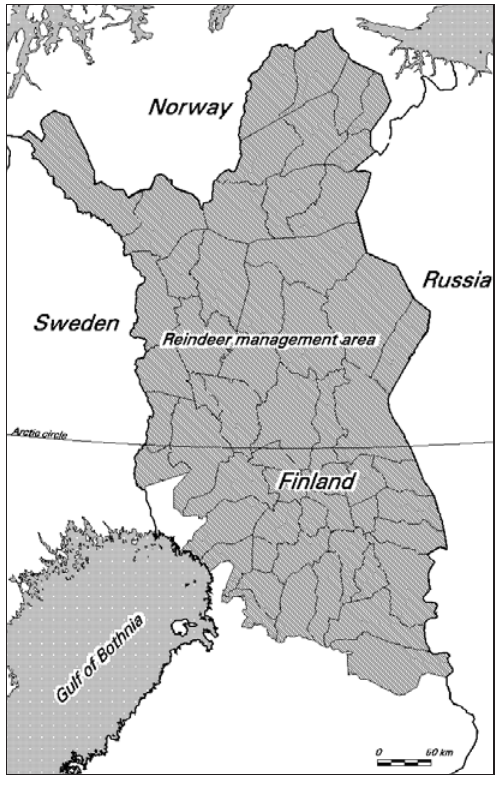
Fig. 1. The semi-domesticated reindeer management area in Finland formed by the 56 separate rein- deer management